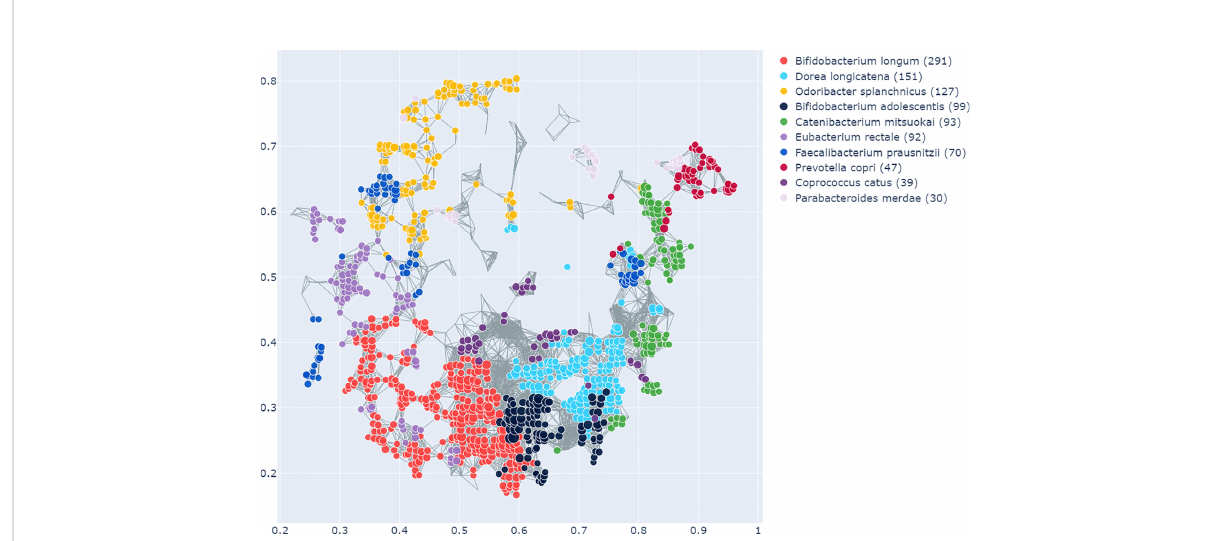
FIGURE 6 Topological Data Analysis (TDA) with Mapper: This fi gure shows the network graph made from the microbiome data. Each node represents a group of samples with similar microbiome pro fi les, each edge represents overlap in the groups. The colours represent the COVID-19 severity groups, enriched with the SAFE algorithm on the network. Speci fi cally, which of the groups has the higher SAFE score at a given node. The fi gure shows that there is clear clustering of the groups across the network, with the low severity group mostly enriched across the lower left of the network graph. The high severity group is enriched in the right and top of the network graph. This suggests different microbiome pro fi les associated with the